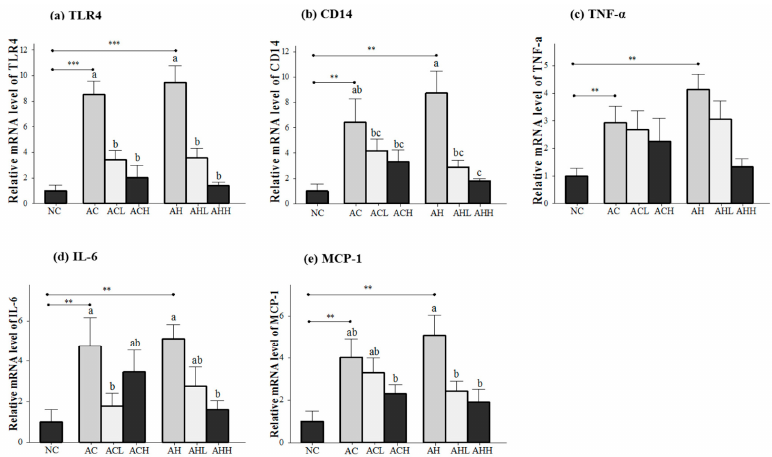
Figure 4. Effects of AK on inflammatory response in the liver of C57BL/6J mice fed with alcohol and